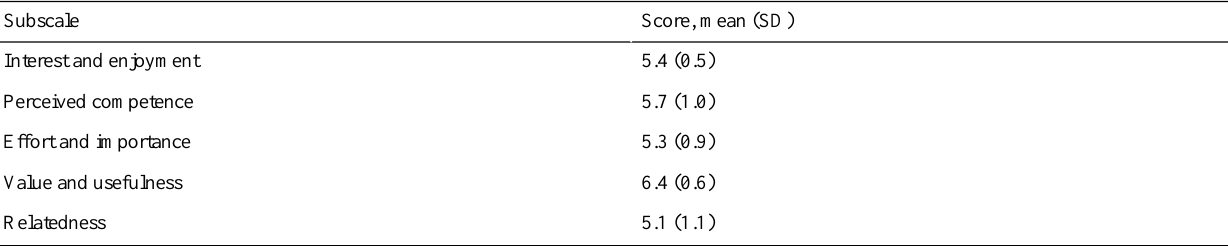
Table 4. Intrinsic Motivation Inventory subscale scores (7-point Likert scale).